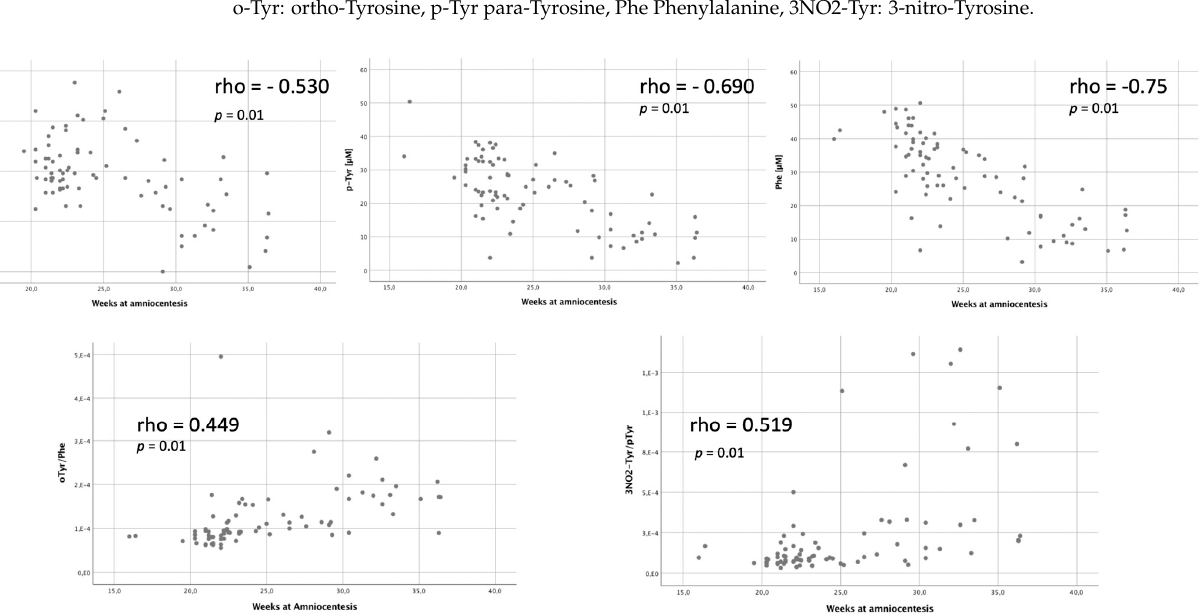
Figure 5. Ortho-tyrosine levels depending on expected cyanosis after birth. The global p of the anal- ysis was p = 0.003. (*) remarks the p obtained in the post-hoc analysis when controls and extreme- cyanosis patients were compared, and (**) is used to indicate p -value for the statistical differences between extreme-cyanosis and no cyanosis. o-Tyr: ortho-tyrosine. When comparing between groups according to our proposed classification, the high- est o-Tyr levels were found in group 3 (low oxygenation and non-obstructed aortic flow CHD) ( p = 0.005) (Figure 6).